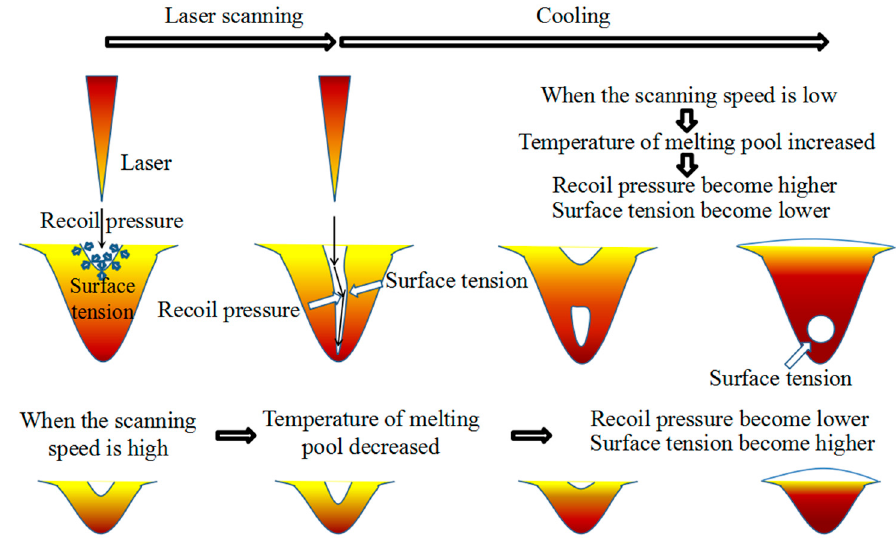
Figure 13. The schematic drawings of the formation mechanism of randomly distributed pores.